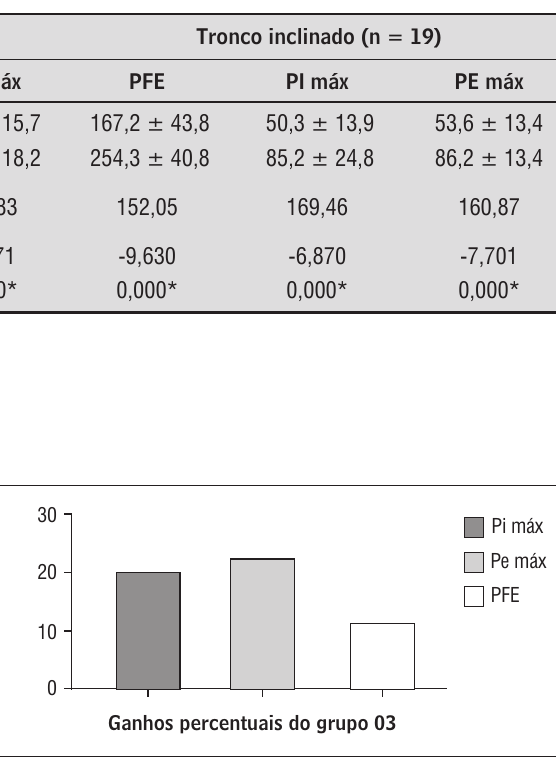
referência ao comportamento dos músculos res- piratórios (20, 21). No entanto, várias posturas poderiam ser adotadas durante a avaliação da força respiratória e cada uma dessas posições, de pé, em decúbito dorsal, em decúbito lateral e sentada oferecem ao indivíduo uma mecânica respiratória diferente